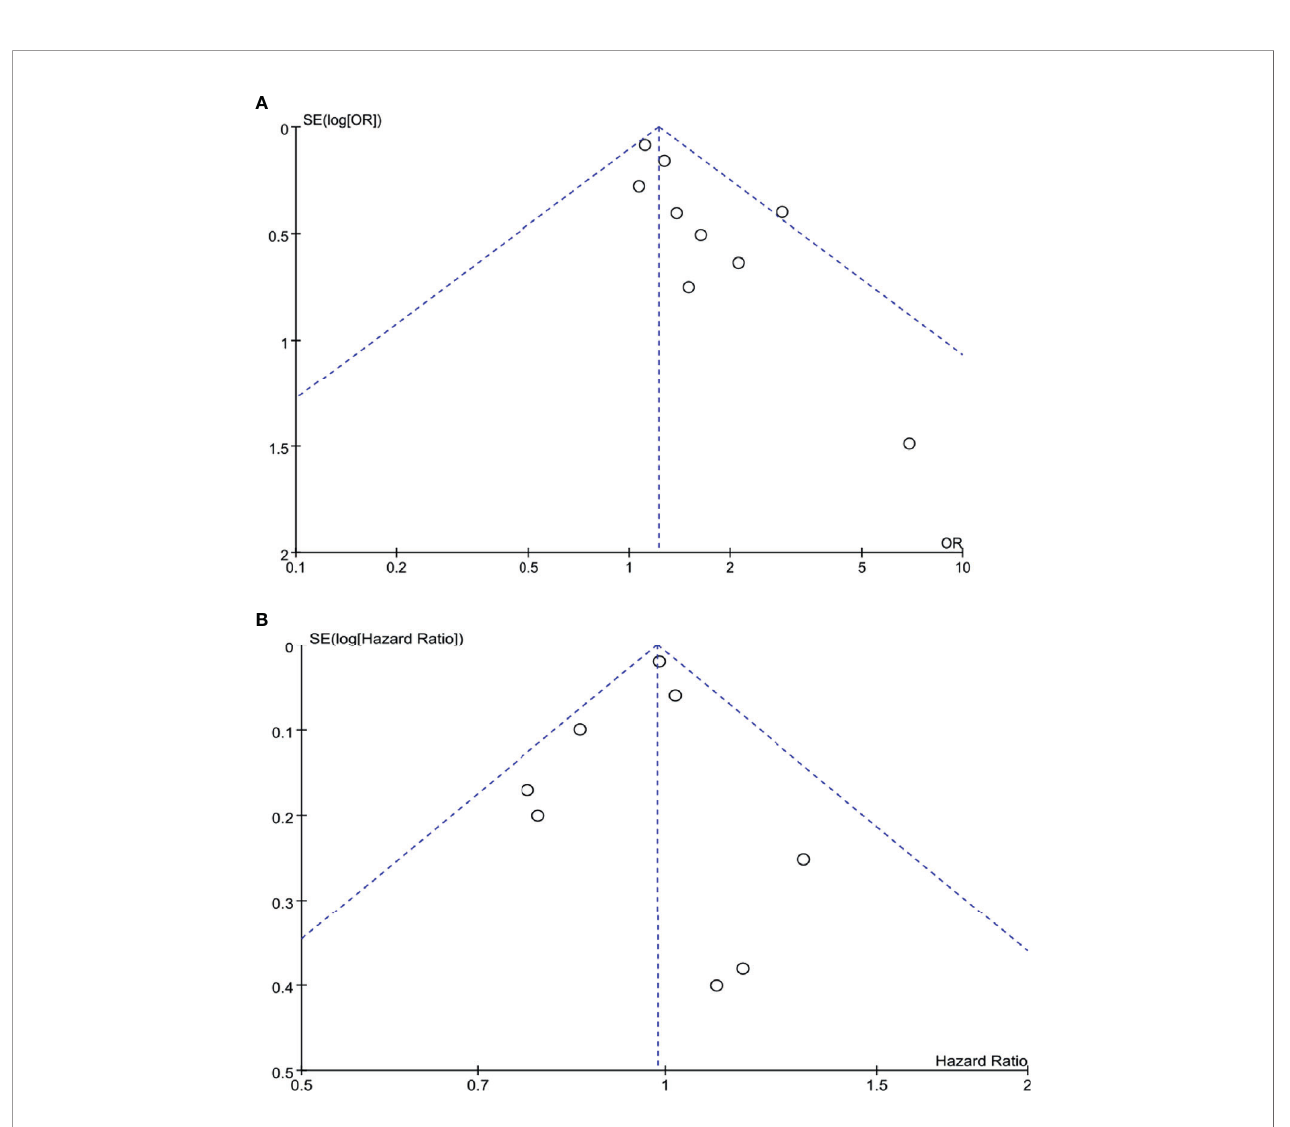
FIGURE 9 | Funnel plots for R0 rate (A) and overall survival (B)